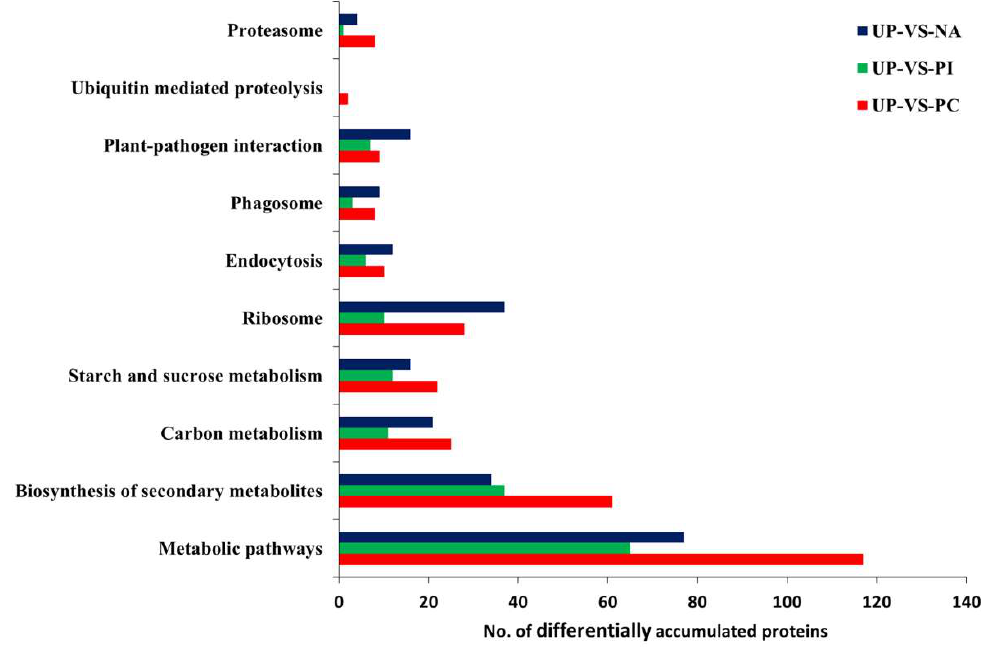
Figure 5. The number of DAPs involved in representative pathways in UP-VS-PC, UP-VS-PI, and UP-VS-NA. Detailed information for these DAPs is listed in Table S9.